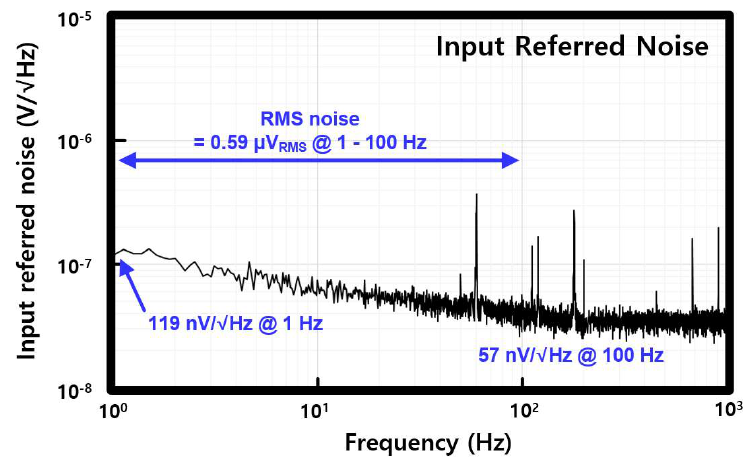
Figure 17. Signal quality measurement result when the CMCP operation is enabled and disabled.